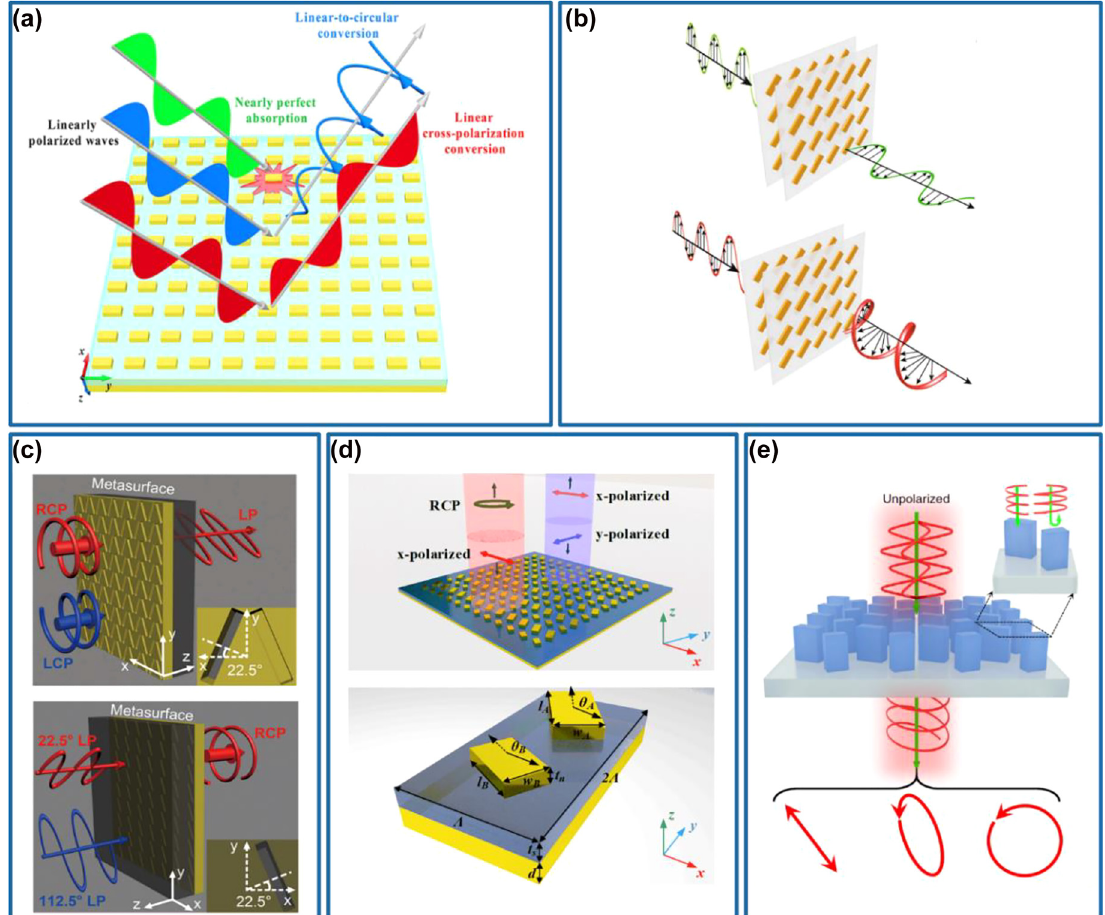
Figure 6: Wavelength-multiplexed, direction-multiplexed, and input-polarization-multiplexed multifunctional meta-waveplates. (a) Sche- matic of the proposed multifunctional metasurface with the functionalities of nearly perfect absorption, linear-to-circular conversion, and linearcross-polarizationconversionatdifferentwavelengths.ReprintedfromRef.[105].(b)Schematicofthemultiwavelengthwaveplateusing a combination of two polarization-sensitive rectangular nanopillar geometries, which functions as an HWP and a QWP at two different and independentwavelengths.ReprintedfromRef.[106].(c)Toppanel:schematicofthemetasurfaceusedasachirallinearpolarizerwhenCPlight is incident in the forward direction. Bottom panel: schematic of the metasurface acting as anisotropic circular polarizer when linear polari- zationlightisilluminatedinthebackwarddirection.Thecorrespondingunit-cellstructuresaredepictedintheinsetwiththeindicatednormal direction of the slits, respectively. Reprinted from Ref. [107]. (d) Top panel: schematic of the dual-functional meta-waveplate that exhibits combined QWP and HWP functionalities for two orthogonal linear polarizations. Bottom panel: schematic of the meta-molecule unit cell. Reprinted from Ref. [108]. (e)Schematicof the all-in-onepolarizerthat canfunction at anarbitrary positionon the Poincar ´ e sphere,which can directly operate with unpolarized incident light and generate arbitrary polarization states, including linear, elliptical, and circular polariza- tions, regardless of the incident polarization state. Reprinted from Ref.